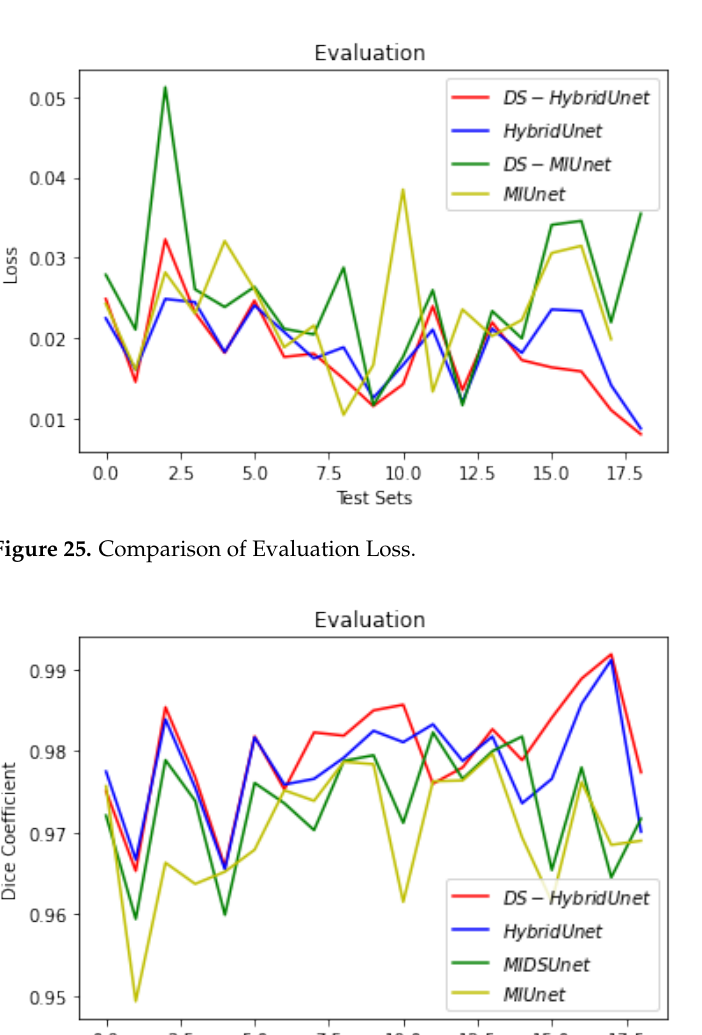
Figure 24. Comparison of Validation Accuracy.